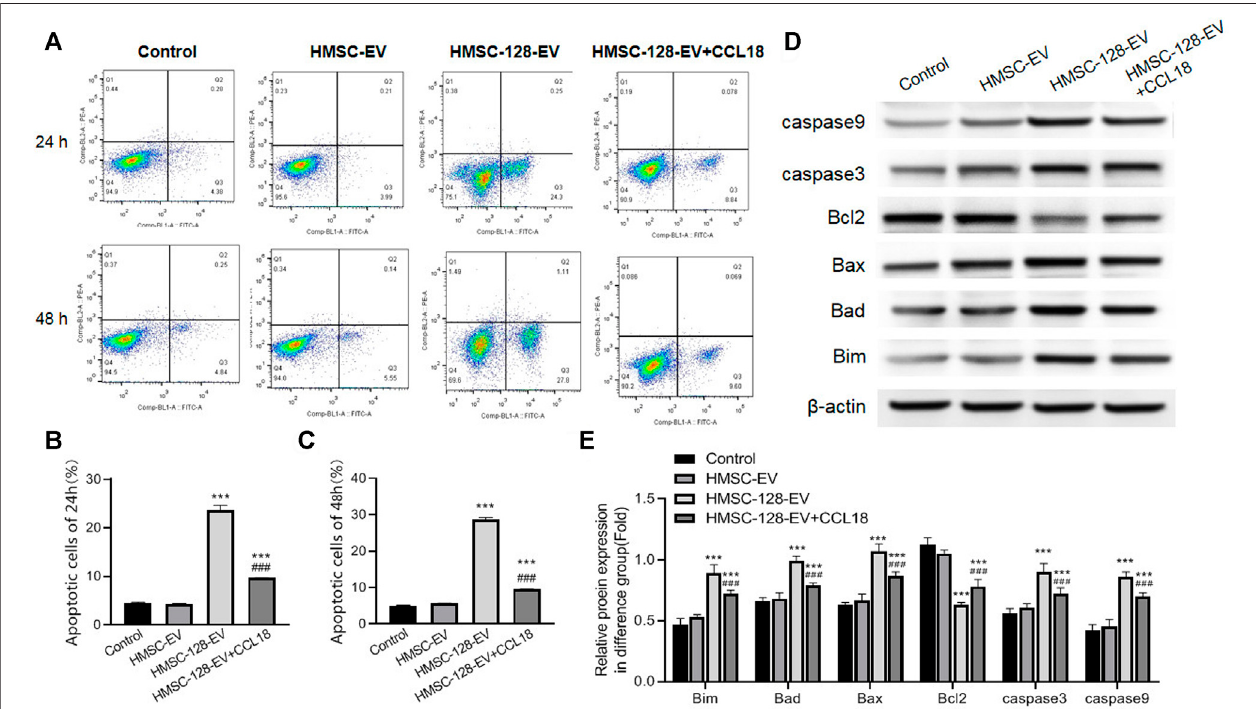
FIGURE 6 | HMSC-128-EV promoted BUC T24 apoptosis. (A) is the result of apoptosis detection using fl ow cytometry (stained by annexin/PI). (B, C) are the apoptosis rates after co-culture for 24 and 48 h. (D, E) are the western blotting typical picture and statistical results of Bim, Bad, Bax, caspase 3, caspase 9 and Bcl2 in eachgroup,respectively.HMSC-128-EVwasabletopromotetheexpressionofBUCT24apoptoticproteinandinhibittheexpressionofsurvivalfactors.*** p < 0.001vs. Control, ### p < 0.001 vs.